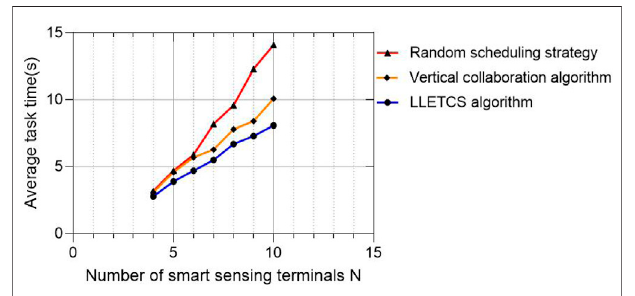
FIGURE 7 | Effect of computing power of smart sensing